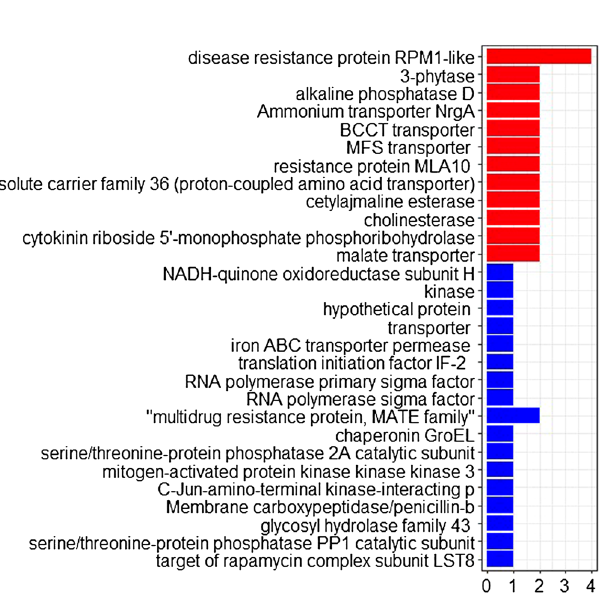
Figure 6. Pathway distribution map of the candidate